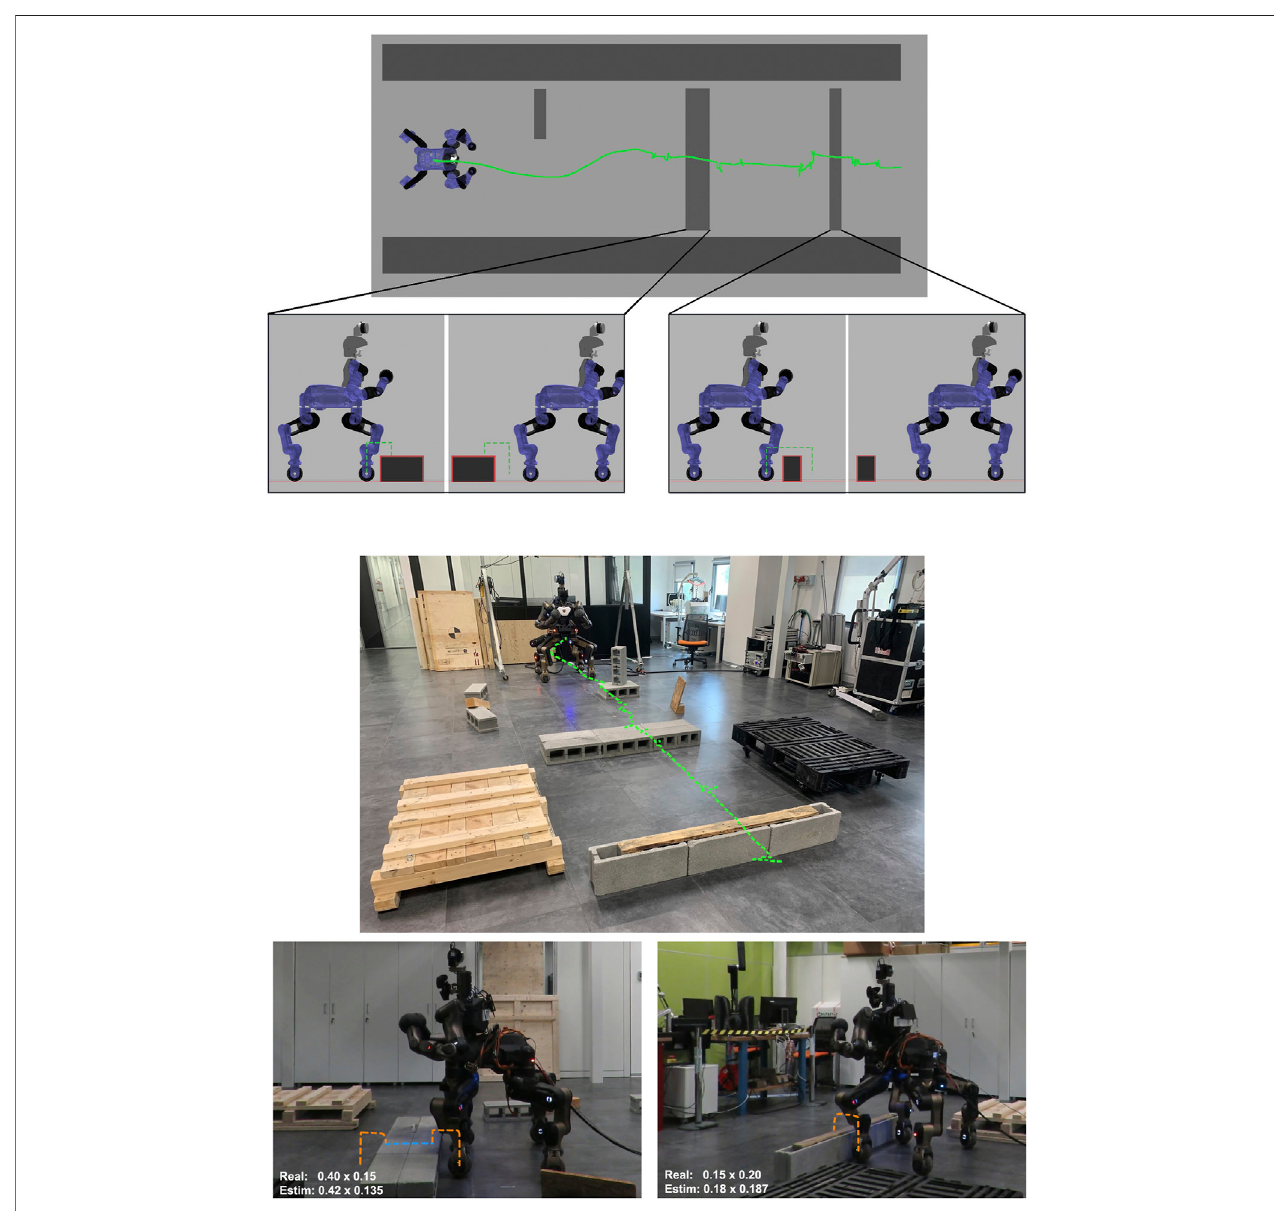
FIGURE13| Finalexperimentinsimulationandinrealworldcase.Thetopdepictsthescenarioconsideredwiththepelvistrajectoryshowningreen.Thesideviews demonstrate the stepping actions, where the orange dashed line shows the trajectory followed by the wheel during the lifted execution while the blue one shows the trajectory followed using the driving primitive. The fi rst obstacle is avoided driving around, the second one stepping on and down, fi nally the last one is crossed stepping over.